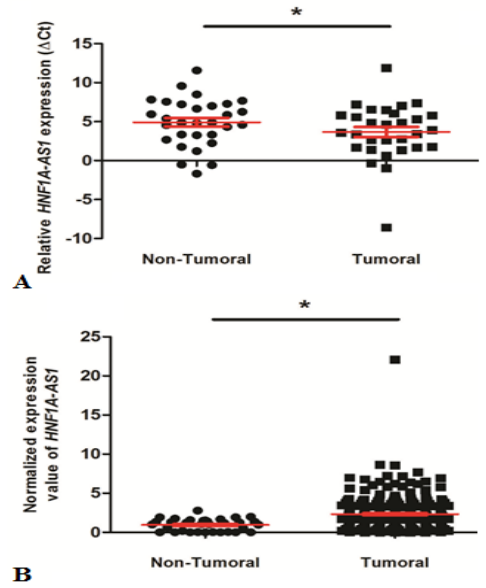
Fig. 1. Expression profile of HNF1A-AS1 in gastric tumoral and adjacent non-tumoral samples of our study group and TCGA cohort. HNF1A-AS1 expression was significantly lower in tumoral samples compared to adjacent non-tumoral ones both in our patients (A) In TCGA cohort; Tumoral samples showed significantly higher HNF1A-AS1 expression levels (B); Data are expressed as means±SEM. The asterisk indicates a statistically significant